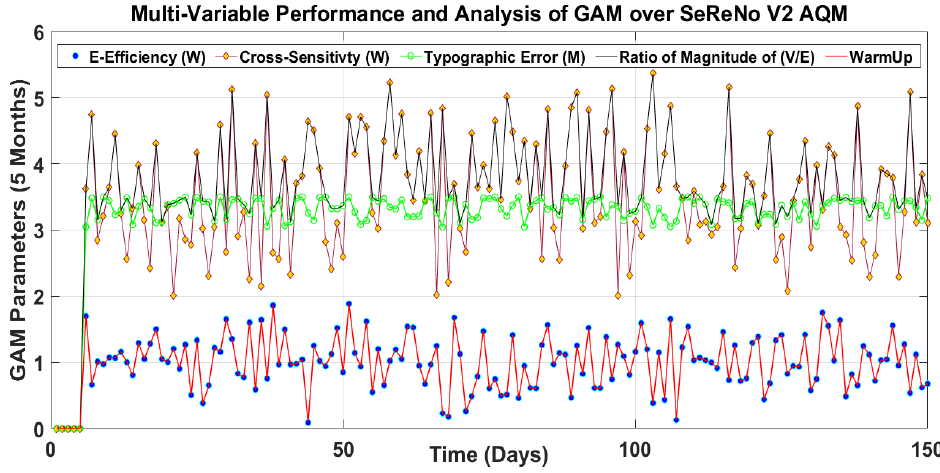
Figure 8. The GAM KPIs for SeReNo V2.